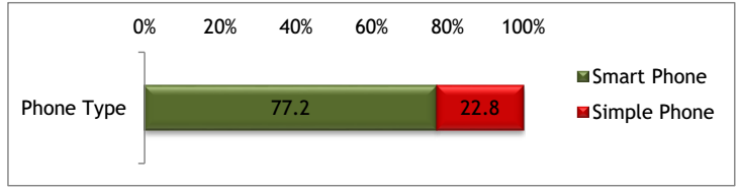
Fig. 2. Transformed information of exogenous variables